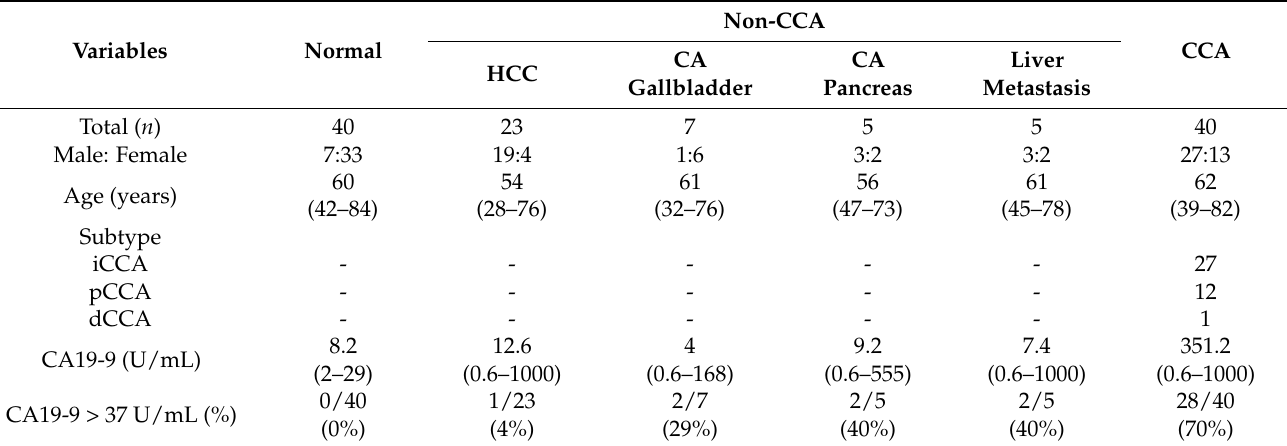
Table 1. Demographics and clinicopathological data of studied